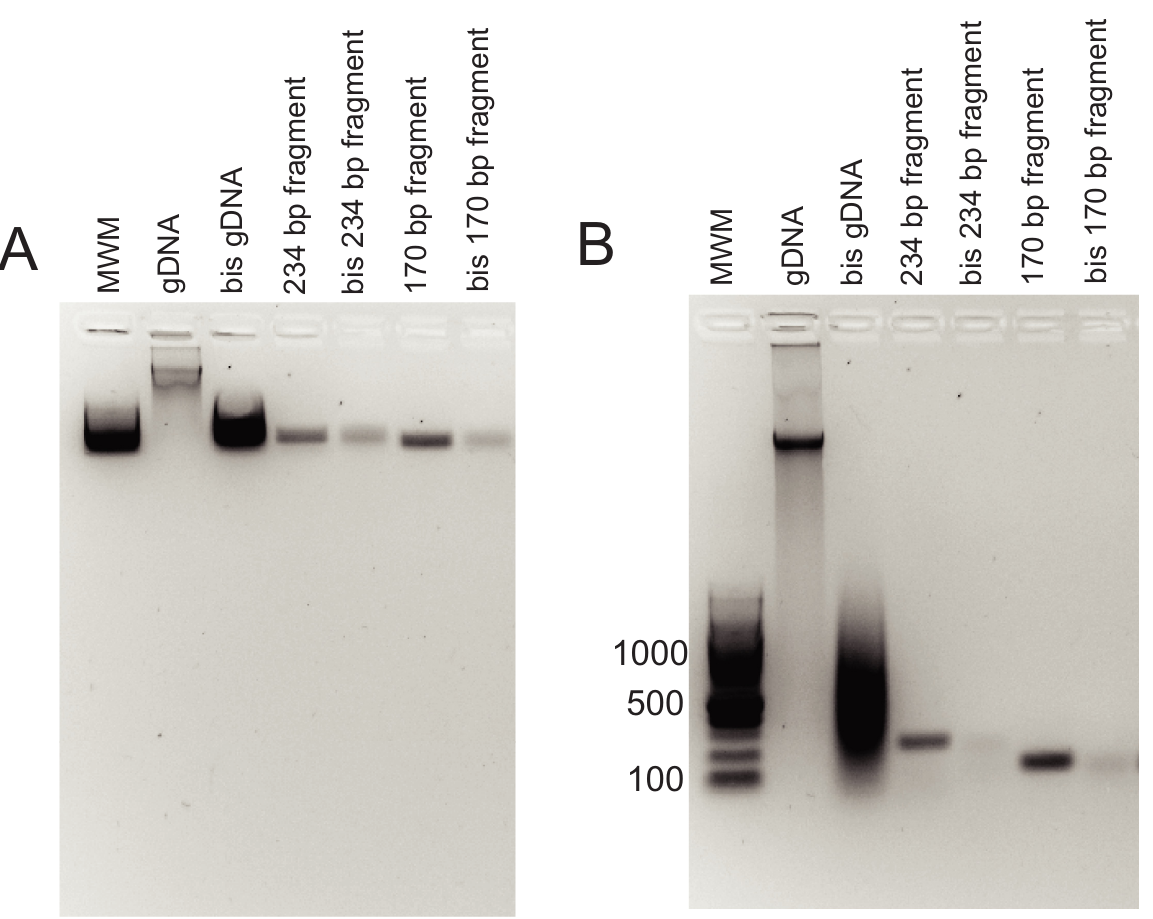
Fig 3. Agarose gel of PCR product and bis-treated PCR product following (A) 15 minutes and (B) 40 minutes of electrophoresis. Size of each PCR product is as indicated. gDNA–untreated genomic DNA; bis gDNA–bis-treated genomic DNA.